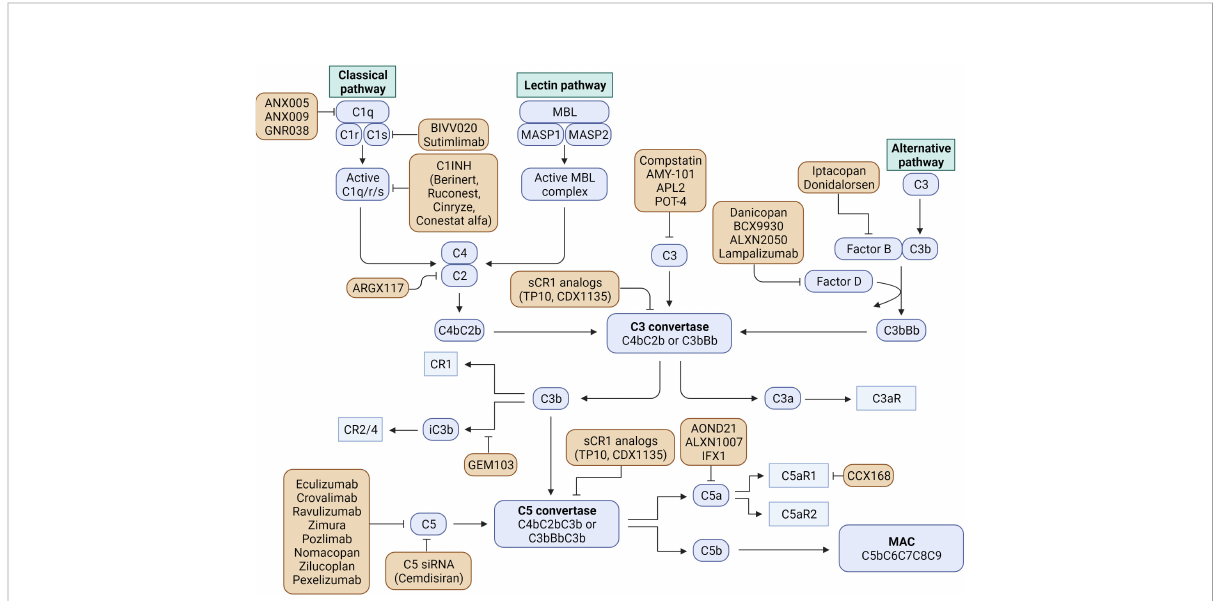
FIGURE 2 Currently available complement inhibitors used in clinical trials of neurologic and non-neurologic diseases (Created with